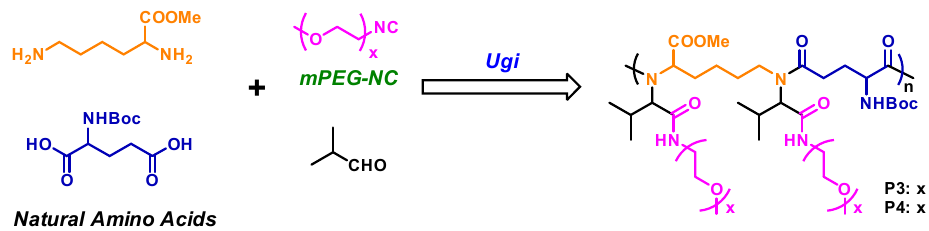
Figure 17. Synthesis of alternating OEGylated poly(amino acid)s via Ugi reaction of natural amino acids. Reproduced with permission [39]. Copyright 2018, American Chemical Society.